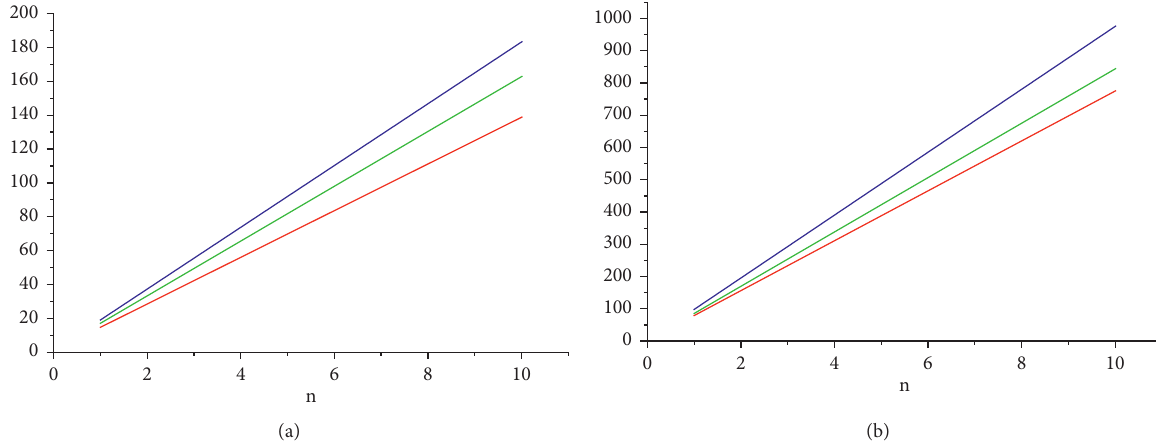
Figure 7: Comparison of general Randic indices of guar gum, HPG and CMG, and CMHPG. (a) R (CMHPG) in blue for α � ( 1/2 ) ; (b) R in green, and R α α � − ( 1/2 )